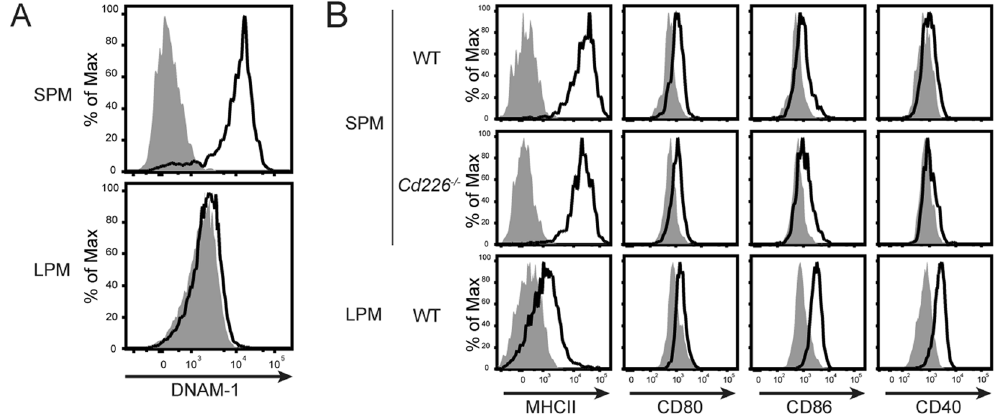
Figure 2. DNAM-1 (CD226) is strongly expressed on SPMs. ( A ) DNAM-1 expression on SPMs and LPMs detected by anti-DNAM-1 mAb. ( B ) Expression of costimulatory molecules involved in antigen presentation on WT SPMs, Cd226 − / − SPMs and LPMs. Open histograms indicate specific mAb and shaded histograms indicate isotype controls. Data is representative of over two independent